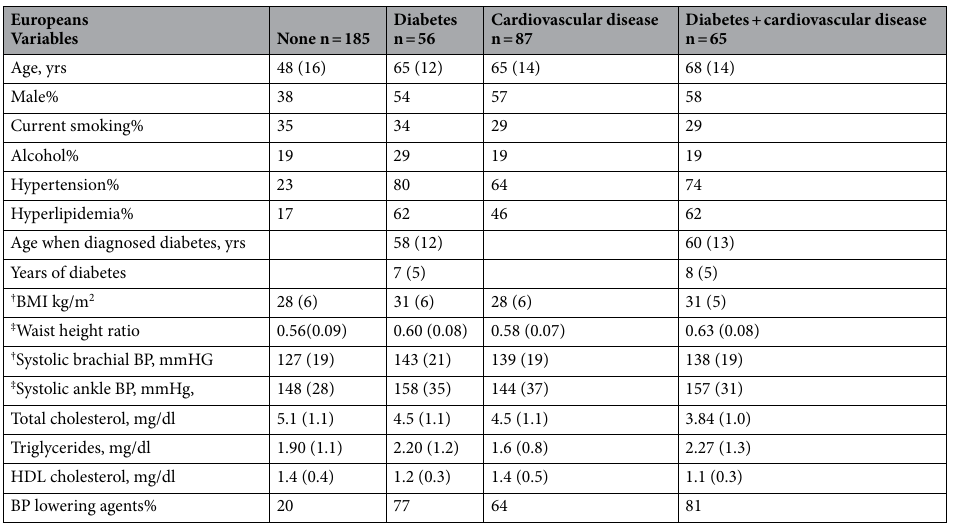
Table 1. Descriptive characteristics of UK Europeans with or without diabetes and /or cardiovascular disease. Values are mean (SD). † standard indicators of concomitant disease. ‡ non-standard characteristics.